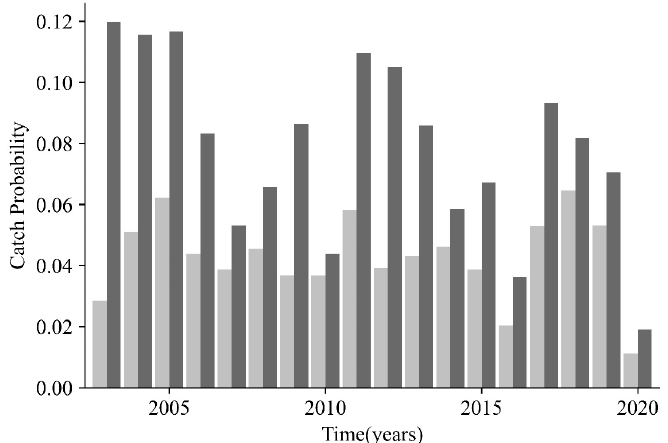
Figure 4. Annual catch probabilities of the fleet in the potential (dark bars) and non-potential (clear bars) fishing areas from the neural network model applied for the fishery of anchovy ( E. ringens ) in Northern Chile.